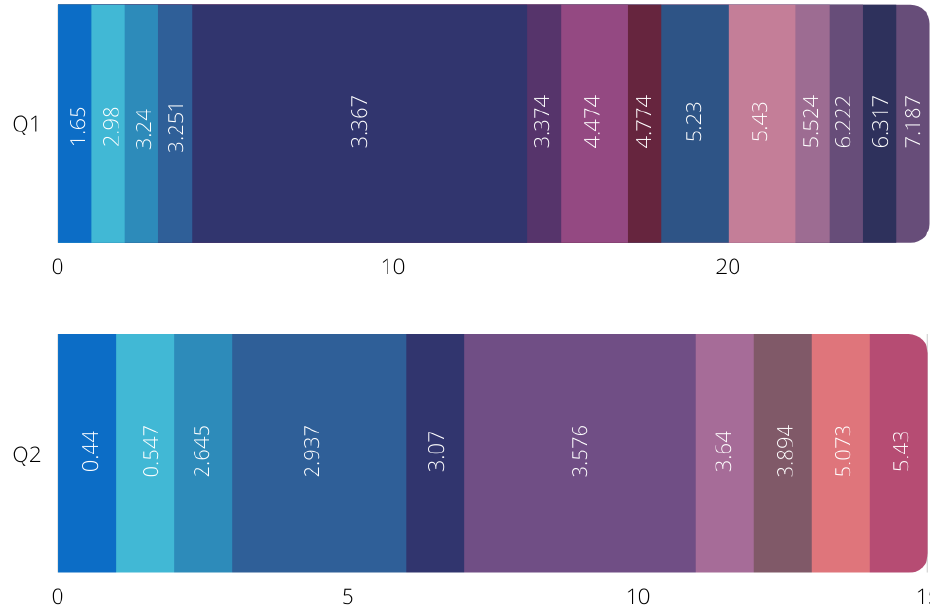
Figure 3. Distribution of Q1 and Q2 journal and their impact factor rating.